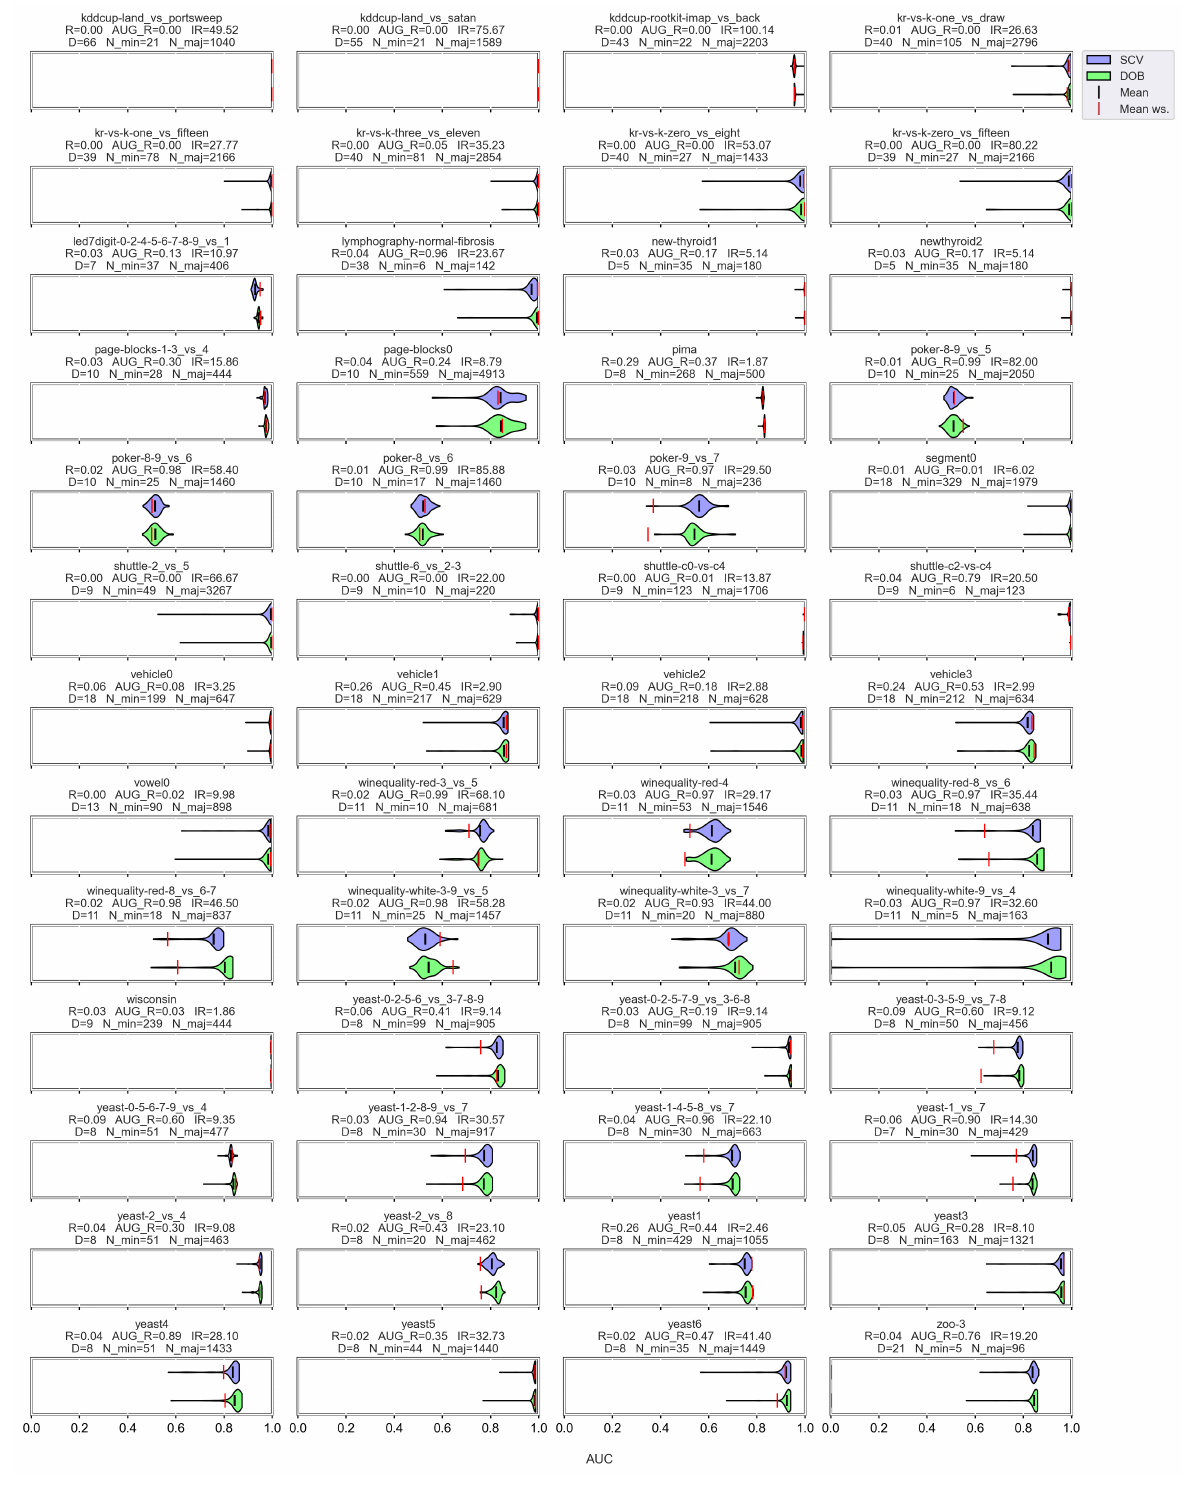
Figure A8. AUC values resulted by the SVM classifier and the named oversamplers per data set of